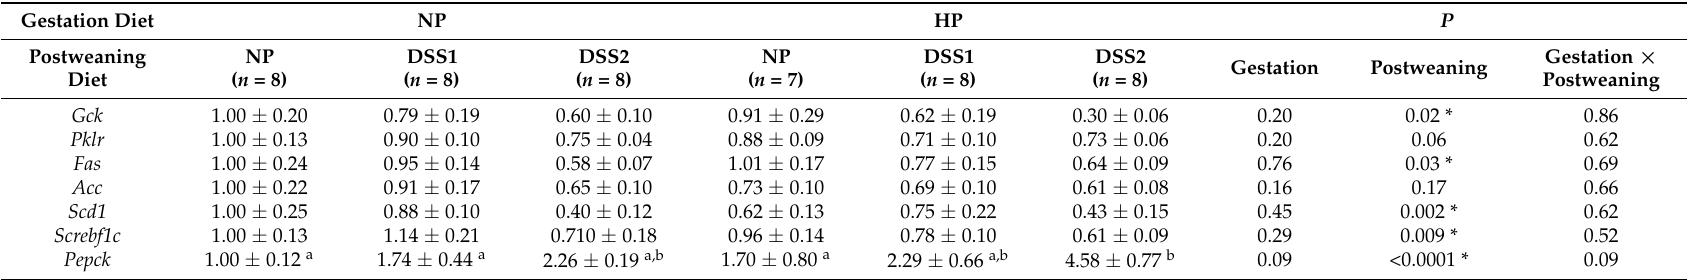
Table 4. Gene expression in liver on